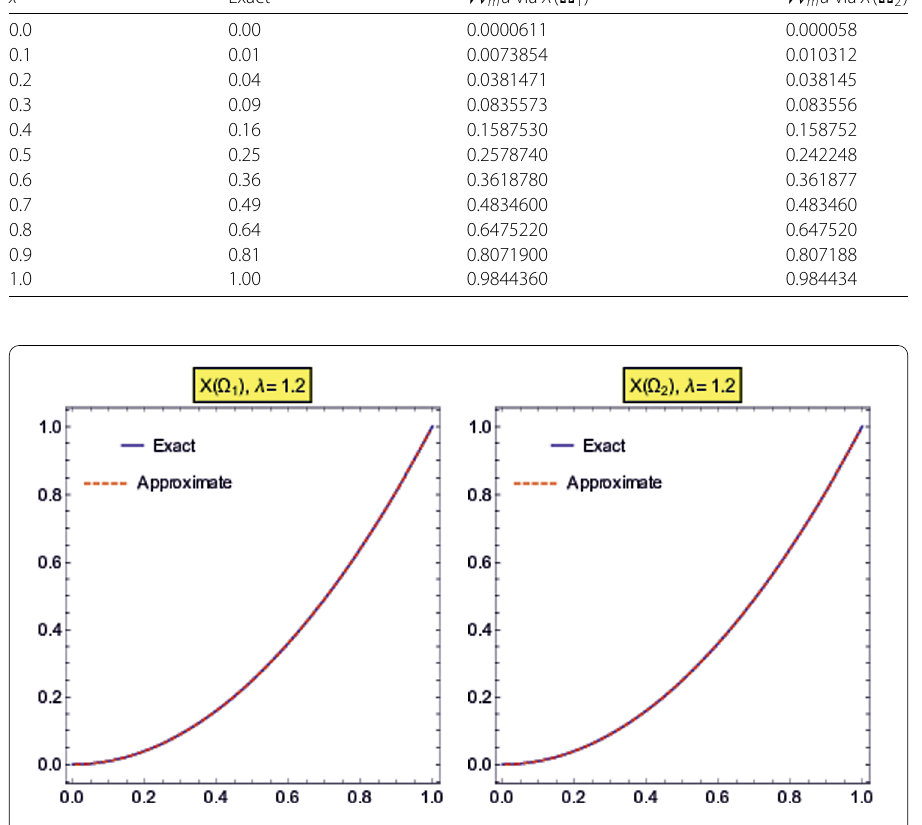
Figure 10 Comparison of the exact and approximate solutions of Example 4.4 for m = 3 and λ =